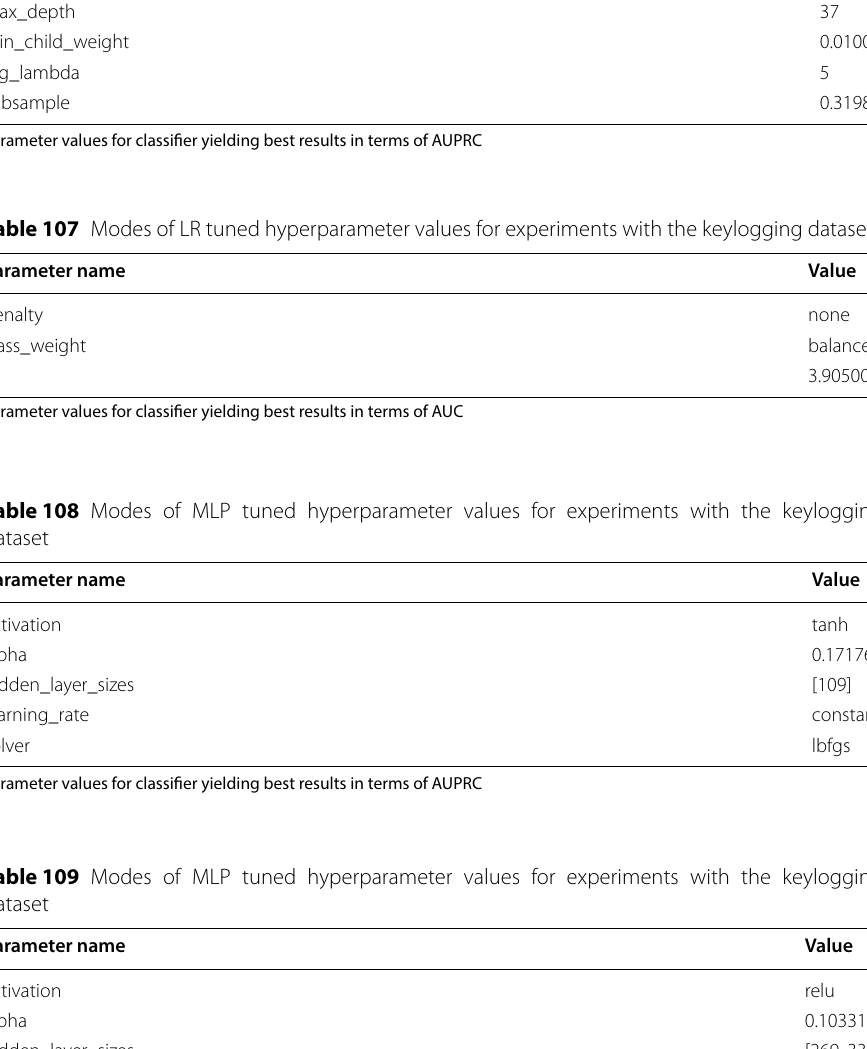
Parameter values for classifier yielding best results in terms of